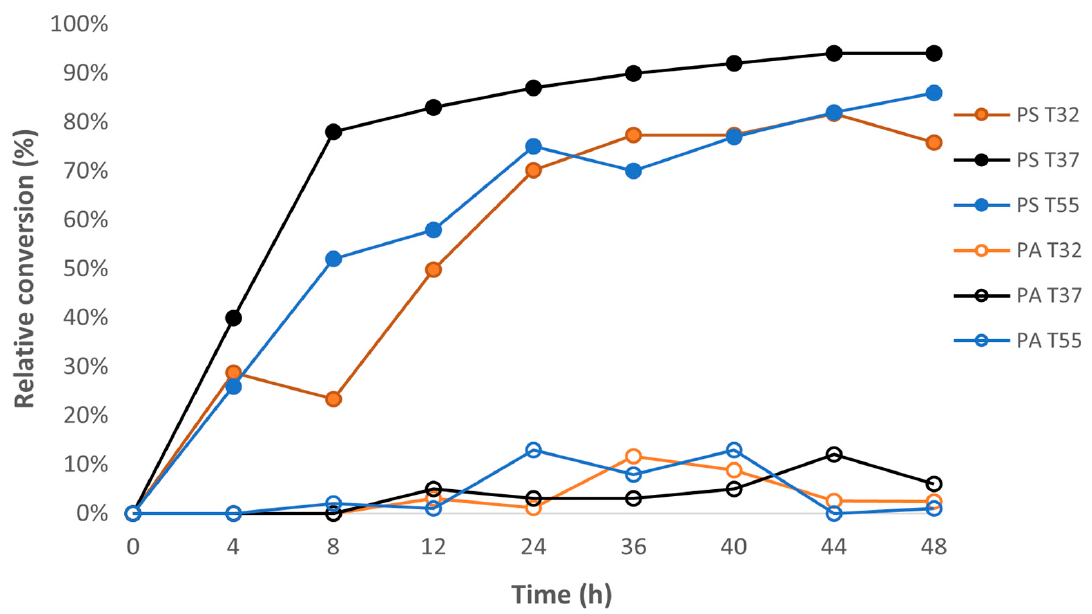
Figure 3. Effect of temperature on the conversion of PC to PS and PA from high-phosphatidylcholine soy lecithin. Reaction conditions: 6 mL of 0.2 M acetate buffer containing 2.5 M L-serine, 0.01 M CaCl 2 , 25 mL ethyl acetate, 0.3 g of soy lecithin, 8 units phospholipase D, pH = 5.5. PS—phosphatidylserine (solid symbols), PA—phosphatidic Acid (open symbols). Error bars lie within the data points.